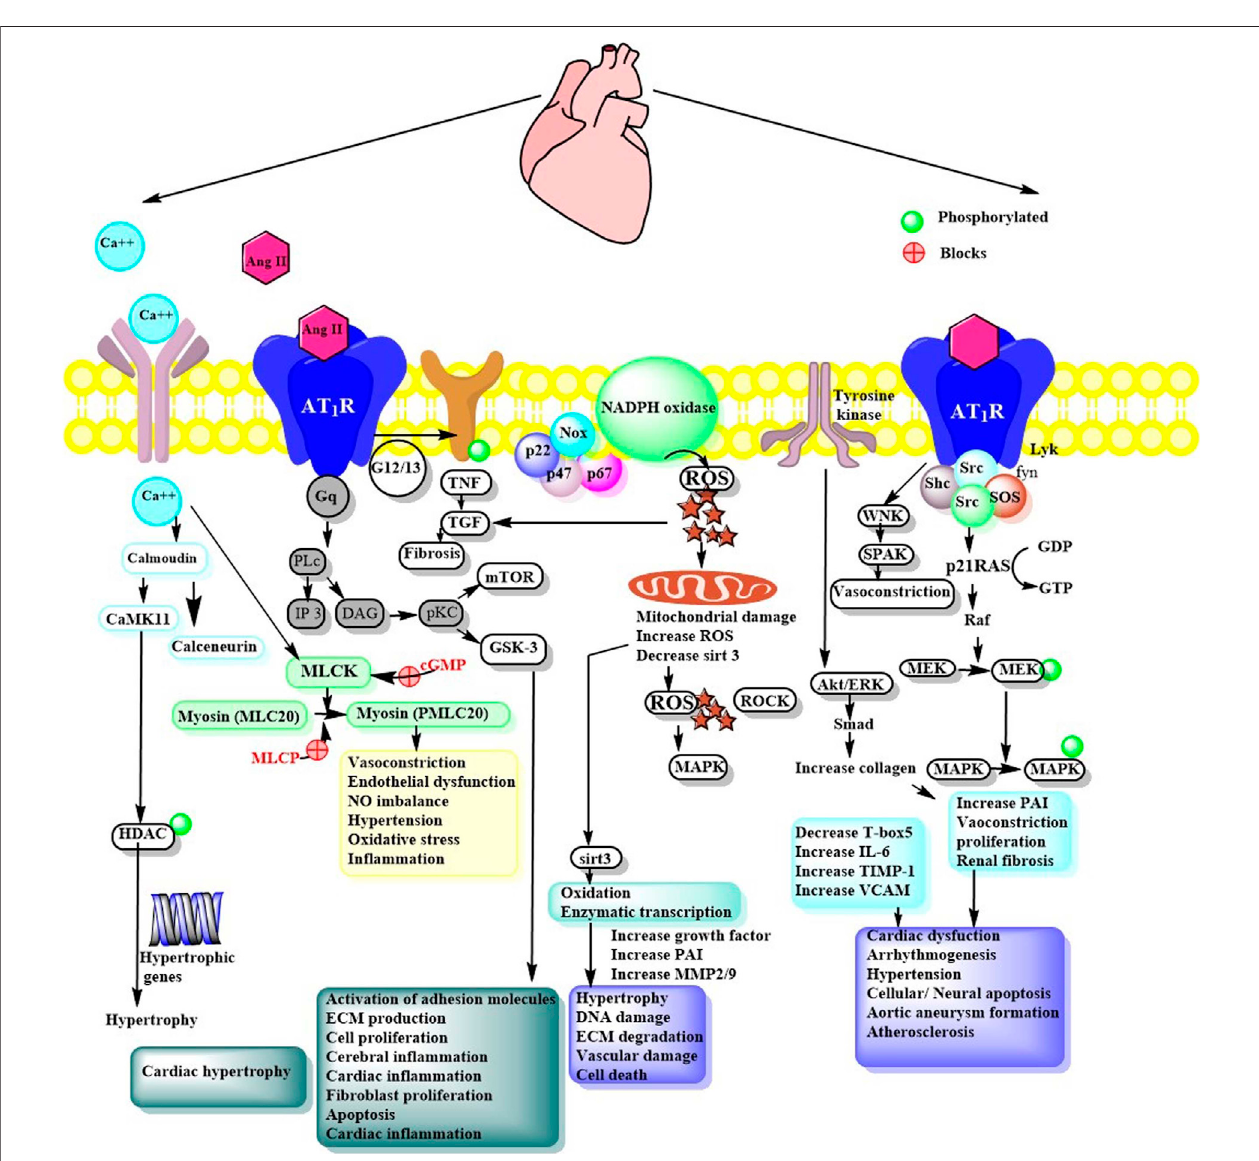
FIGURE 2 | Ang II signaling via AT 1 R mediated pathways. Ang II, Angiotensin II; Ca ++ , Calcium; CaMKII, Ca2+/calmodulin-dependent protein kinase II; NFAT, Nuclear factor of activated T-cells; HDAC, Histone deacetylases; PLc, phospholipase C; IP3, Ionositol triphosphate; DAG, Diacyl glycerol; pKc, Protein kinase; CaMKII, Calcium/calmodulin- dependent protein kinase-II; NFAT, Nuclear factor of activated T-cells; MLCK, Myosin light chain kinase; MAPK, Mitogen activated protein kinase; PAI, Plasminogen activator inhibitor; NFKB, Nuclear factor-kB; MMP, Matrix metalloproteinase; TIMP, Tissue inhibitor metalloproteinase; VCAM, Vascular cell adhesion molecule; PVN, Paraventricular nucleus; ECM, Extracellular matrix; HDAC, Histone deacetylase; GTP, GDP, Nucleotides; Akt, Protein kinase B; cGMP, Guanosine3 ’ ,5 ’ cyclicmonophosphate;ROS,Reactiveoxygenspecies;Grb2,Growthfactorreceptorboundprotein2;TGF,Tissuegrowthfactor;PLC,phospholipase C; mTOR, mammalian target of rapamycin; GSK, Glycogen synthase kinase; TNF, tumor necrosis factor; Sirt: Sirtuin; MMP, Matrix metalloprotease; ERK, extracellular- signal-regulated kinase; WNK, lysine de fi cient protein kinase 1; SPAK, SPS1-related proline/alanine-rich serine-threonine kinase.